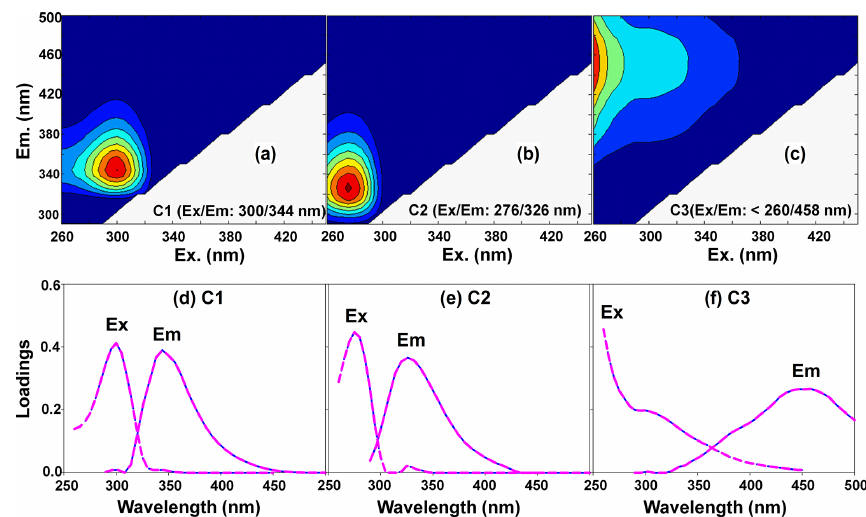
Figure 9. EEM contour plots of the three fluorescent components C1–C3 (a–c) identified using EEM–PARAFAC in the fine-mode aerosol particles ( D < 2 . 5µm) collected over the Southern Ocean and the Amundsen Sea, as well as the excitation and emission spectra of C1– C3 (d–f) .